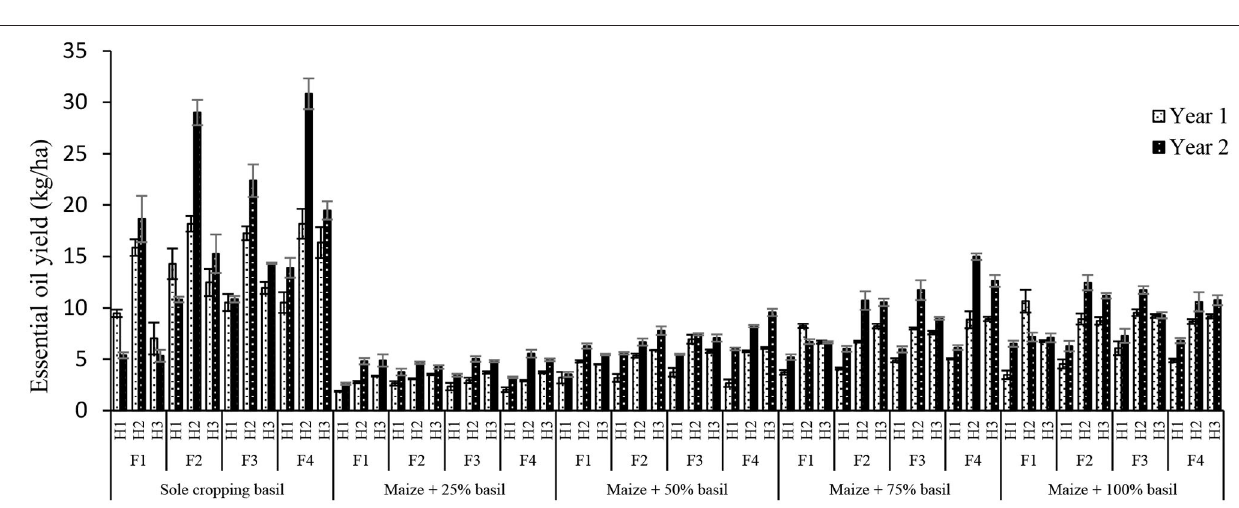
FIGURE 4 | Mean comparisons of interaction of cropping patterns and N 2 fixing bacteria in different harvest during two growing seasons on essential oil yield of basil. I1, I2, I3, I4, and I5: sole cropping of basil, the additive intercropping of maize + 25% basil, maize + 50% basil, maize + 75% basil and maize + 100% basil, respectively. F1, control; F2, 100% chemical fertilizer (N); F3, Azospirillum brasilense and Azotobacter chroococcum ; F4, integration of A. brasilense and A. chroococcum + 50% nitrogen chemical fertilizer and H1, first harvest; H2, second harvest; and H3, third